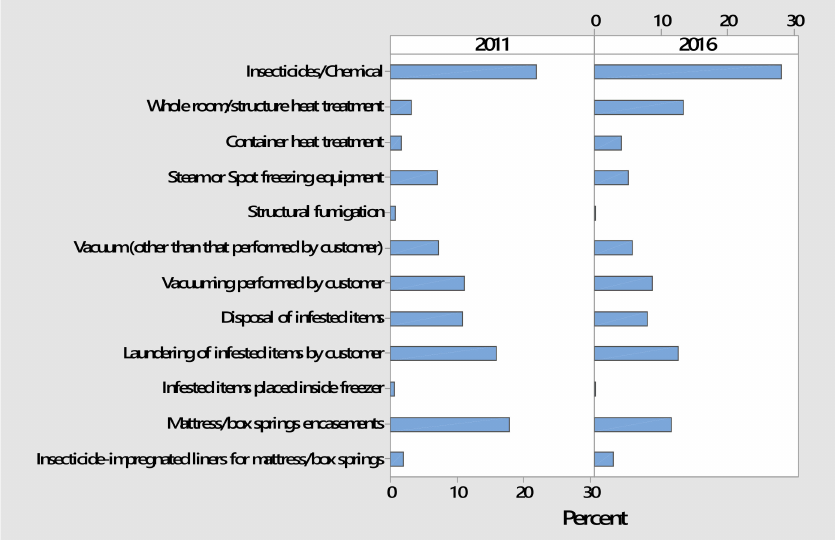
Figure 6. Percentages of treatment types used by PMP respondents in 2011 and